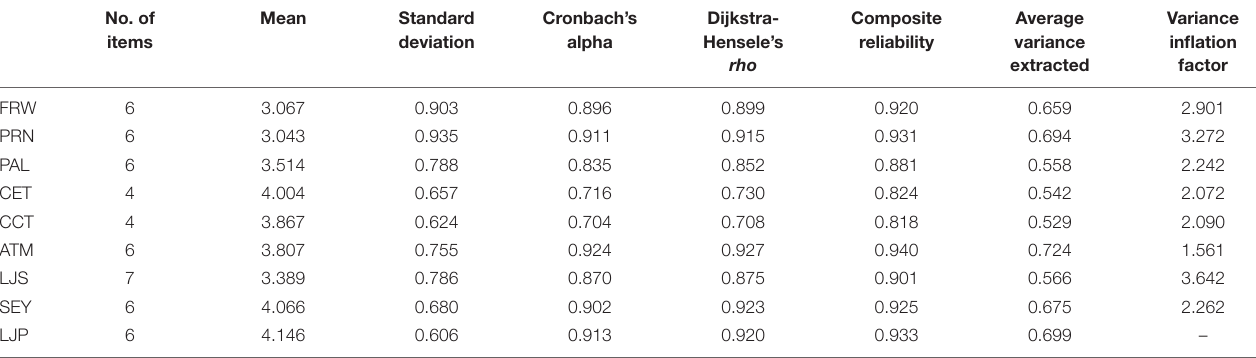
TABLE 3 | Reliability and validity results.